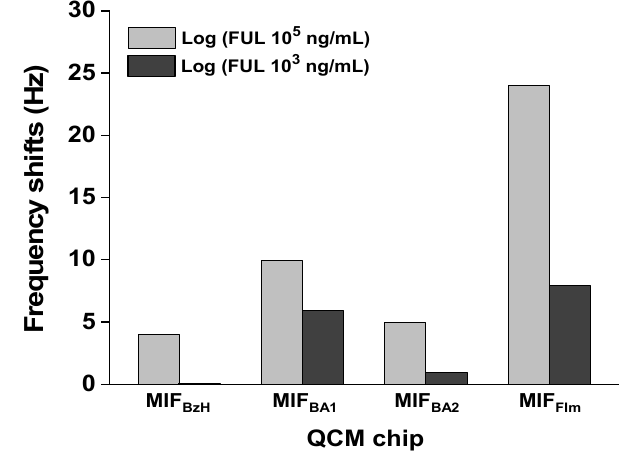
Figure 2. The frequency shifts obtained on FUL binding by constructing MIFs using pseudo-template BzH or FIm (MIF BA1 , MIF BA2 , and MIF FIm ). The compositions of MIFs are shown in Table 2. A mixed solution of heptane/acetone (95/5, v / v ) was used for circulating, washing, and testing. MIF FIm : Acr-L-Ser-NHBn, Am, and EBAA (at a molar ratio of 1:1:2). BzH = benzylaldehyde; FIm = 2-formylimidazole; FUL = 2-furaldehyde.